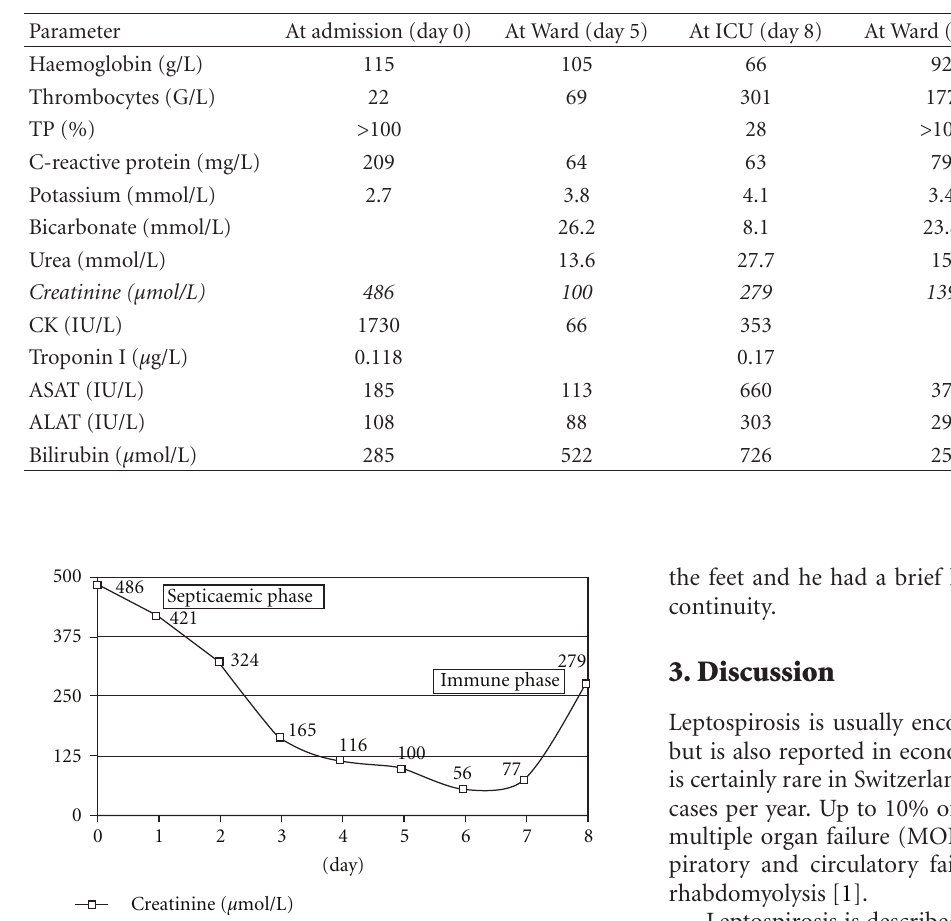
Table 1: Laboratory parameters at admission and during evolution of Weil’s disease.